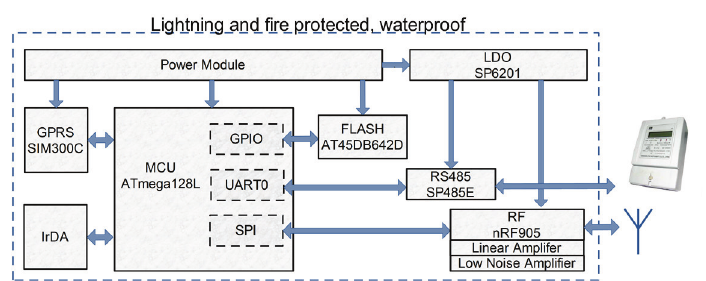
Figure 3. Hardware architecture of a data